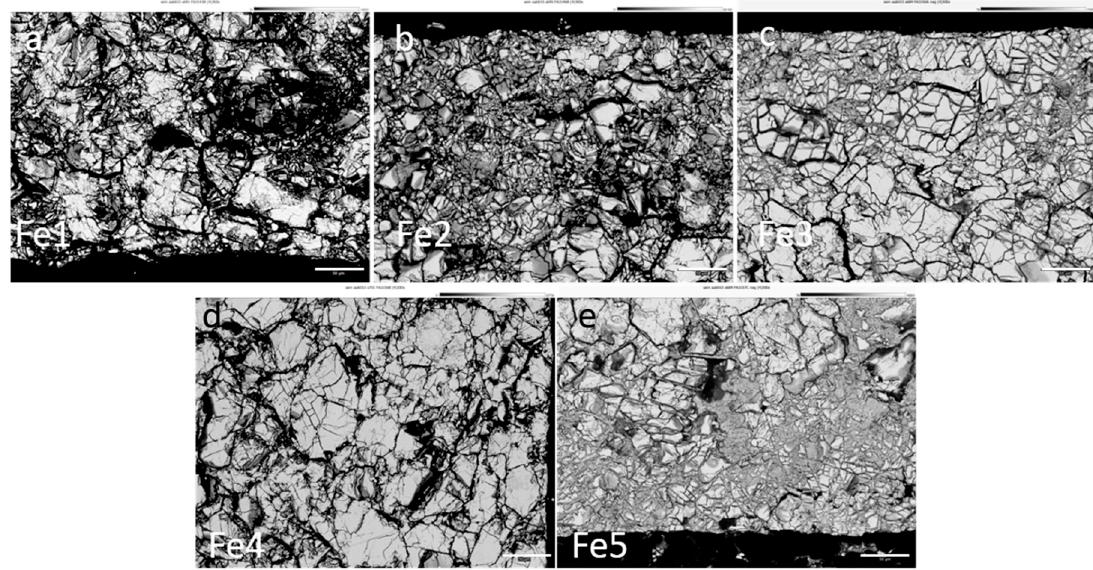
Figure 7. SEM micrographs of the negative electrodes of cells ( a ) Fe1, ( b ) Fe2, ( c ) Fe3, ( d ) Fe4 and ( e ) Fe5 after cycle life testing at RT. The scale bar represents 50 µm. Table 5. Chemical compositions (at%), determined by ICP, of the negative electrodes after cycle life testing. Cell Mm Ni Co Mg Al Fe Fe1